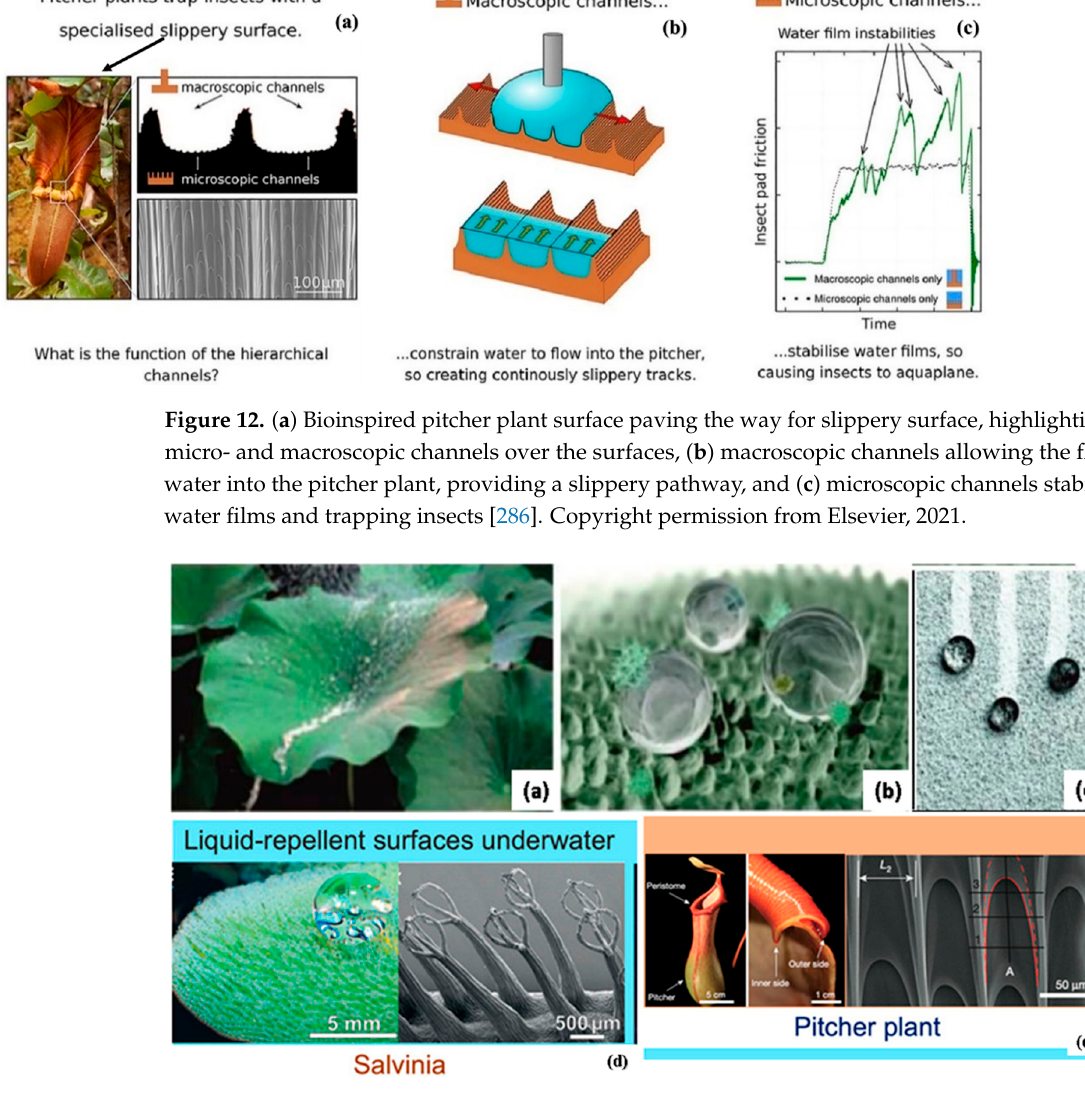
Figure 13. Biomimetics surface resembling the morphology of ( a , b ) normal lotus leaf and computer graphics embedded lotus leaf, ( c ) self-cleaning phenomena on painted surface mimicking lotus effect, ( d , e ) air-infused liquid repellent surface of Salvinia and the pitcher plant [176,283]. Copyright permission from ACS, 2022. Table 4. The tribological behavior of various biomimetics surfaces by